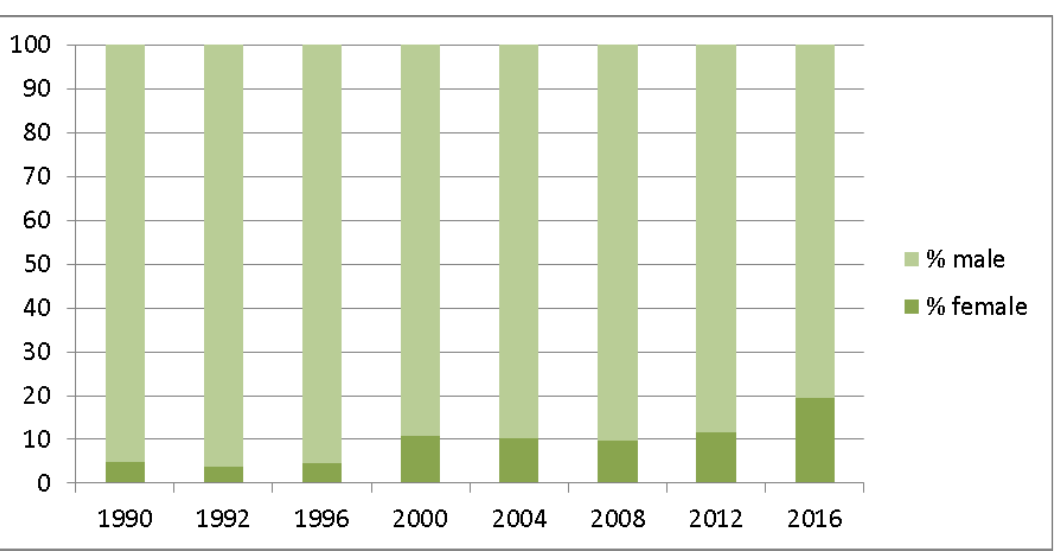
Figure 1: The percentage of women in the Romanian Parliament Source: